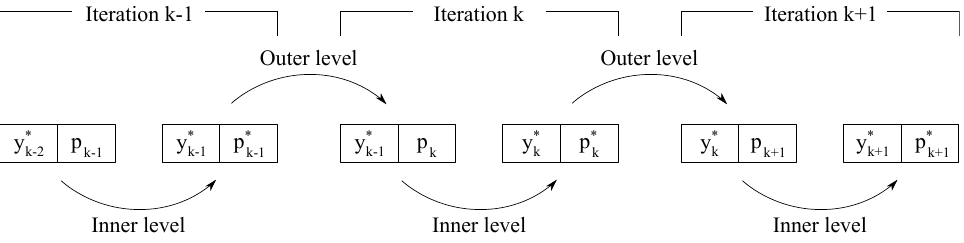
Figure 1. Schematic representation of the bilevel approach acting on a single